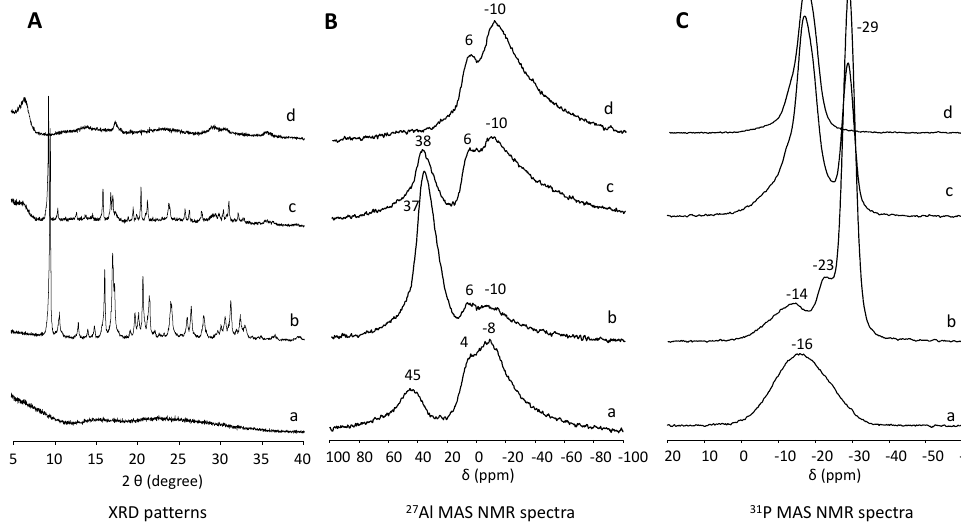
Figure 5. XRD patterns ( A ), and 27 Al ( B ) and 31 P ( C ) MAS NMR spectra of the synthesis mixture before heating ( a ), and as–made solids obtained under autogenous pressure ( b ), 50 MPa ( c ) and 200 MPa ( d ) at 150 °C for 24 h using the diluted synthesis mixture (H 2 O/Al 2 O 3 = 50). Pure SAPO-18 phase was observed in the XRD pattern of the sample obtained under autogenous pressure. The 27 Al MAS NMR spectrum shows a main resonance centered at 37 ppm assigned to tetrahedral Al atoms accompanied by two minor broad signals centered at 6 and − 10 ppm assigned a mixture of penta- and octa-coordinated Al species present in unreacted Al source and amorphous aluminophosphate [32,33]. The 31 P MAS NMR spectra show the main resonance centered at − 29 ppm associated to tetrahedrally coordinated P atoms, a resonance centered at − 23 ppm and a broad signal centered at − 14 ppm assigned to P atoms which are coordinated to H 2 O molecules forming P(OAl) x (H 2 O) y , where x = 4 − y, these P species are mainly found at framework defects or on the outer surface of the crystals